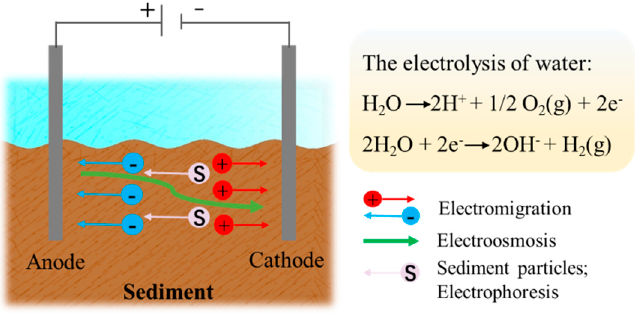
Figure 1. Schematic diagram of EKR (The most important electron transfer reactions at electrodes is the electrolysis of water).